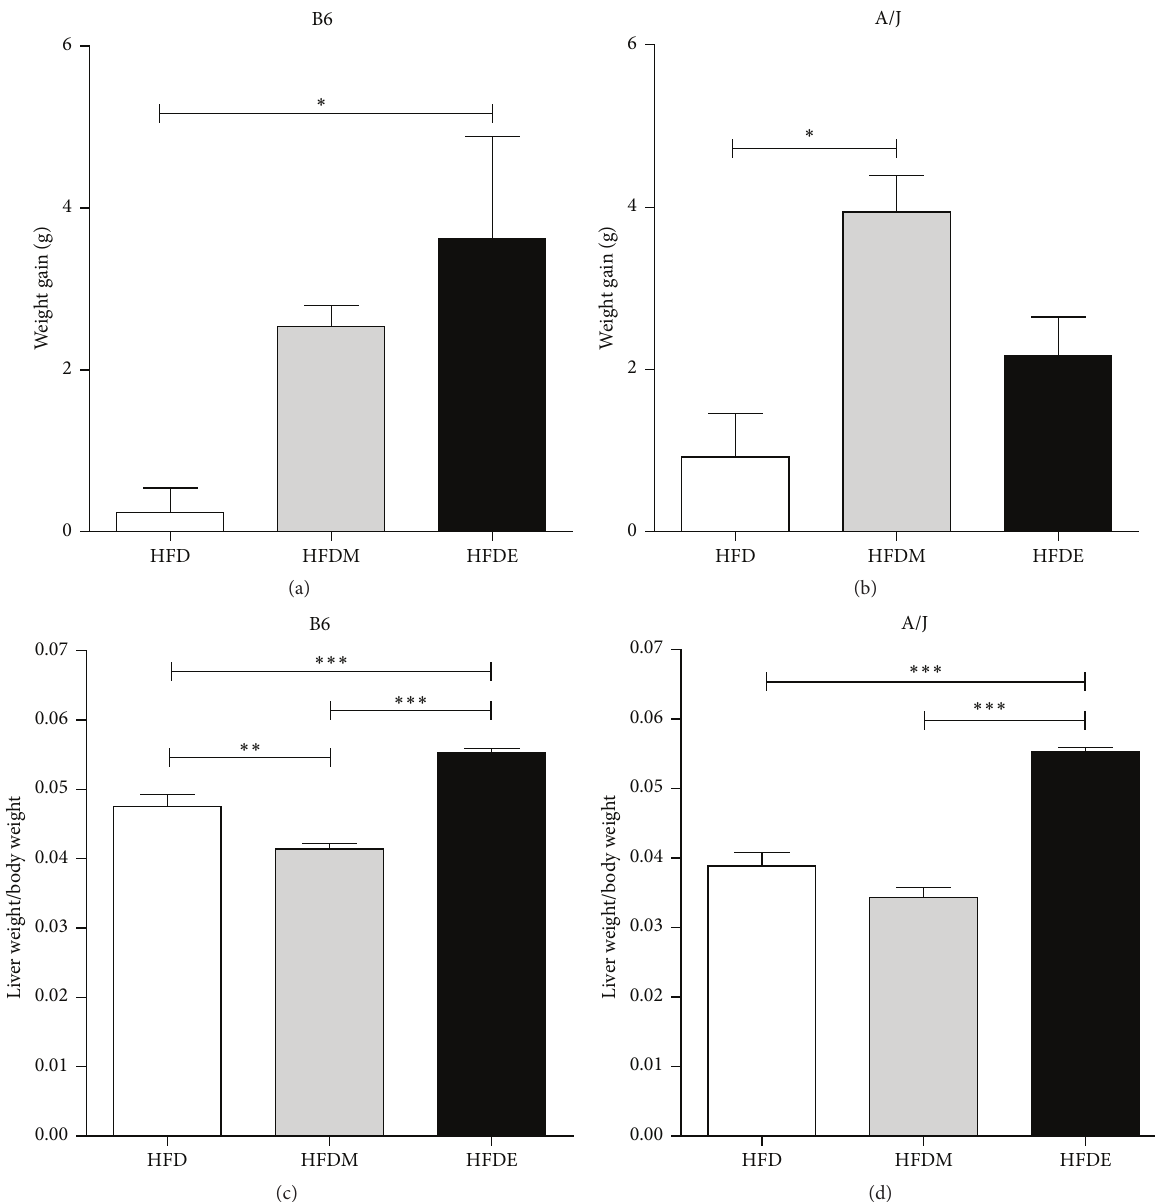
Figure 1: Body weight gain and development of hepatomegaly in B6 and A/J mice fed high fat diets containing ethanol. Before and after 10 weeks of treatment, B6 (a) and A/J (b) mice were weighed and the differences between initial and final weight were expressed in grams (g). Hepatomegaly was evaluated considering the liver weight/body weight ratio in B6 (c) and A/J (d) mice. Results from both B6 and A/J mice ( 𝑛 ≥ 5 ) were evaluated by ANOVA one-way and Tukey as a posttest. Values represent means and standard error. The differences are represented by ∗ 𝑃 < 0.05 , ∗∗ 𝑃 < 0.01 , and ∗∗∗ 𝑃 < 0.001 . HFD: high fat diet, HFDM: HFD containing maltodextrin, HFDE: HFD containing